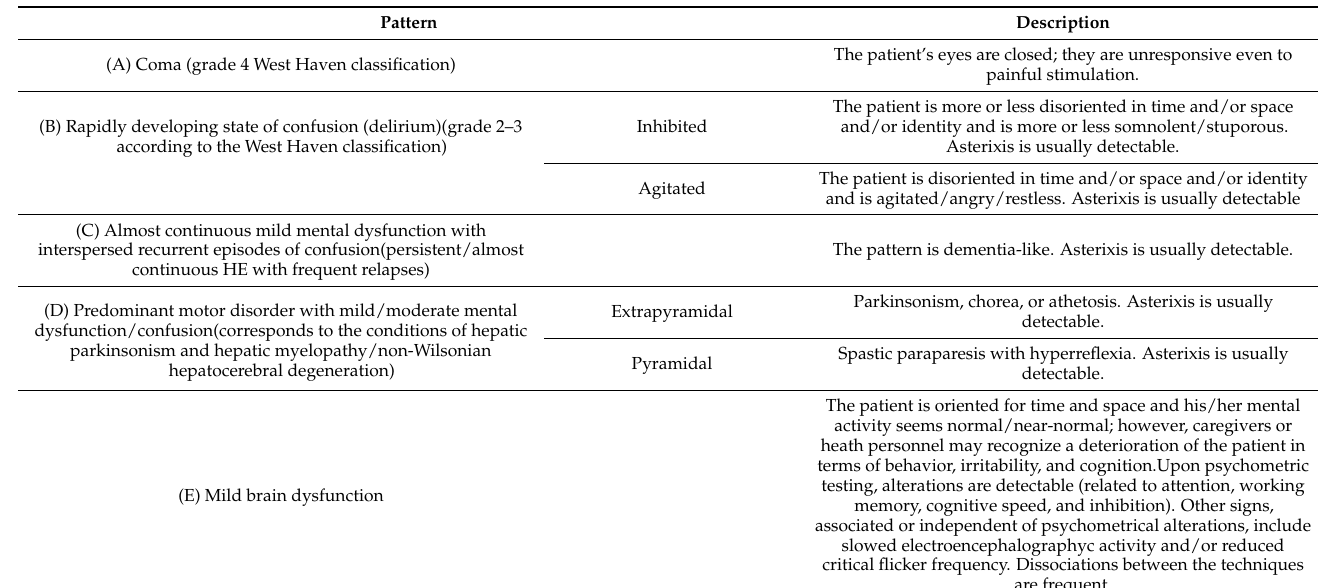
Table 2. Phenotypes of